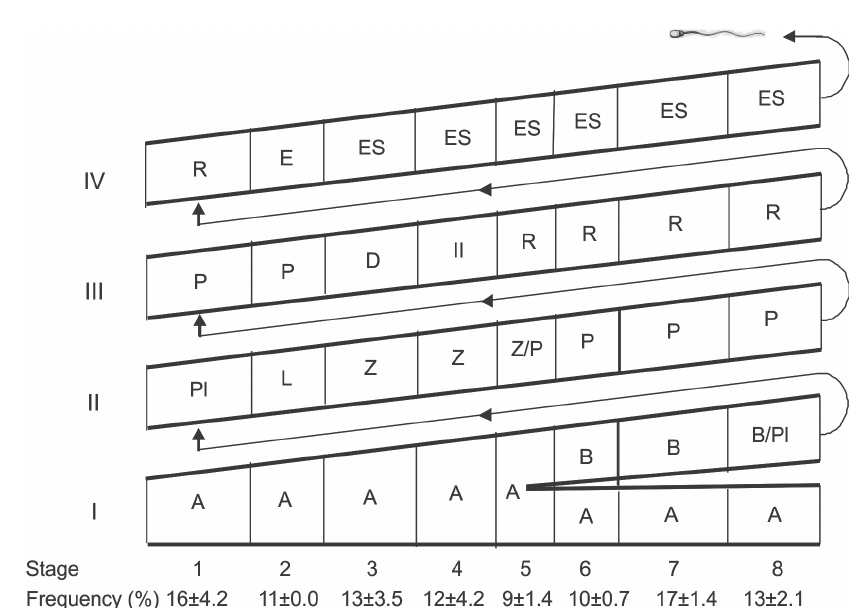
Figure 10. Cell composition and frequency (%) of the stages (1-8) of the cycle (I-IV) of the seminiferous epithelium of the large fruit-eating bat; column width, representing each stage, is proportional to its frequency. (A) Type-A spermatogonium, (B) type-B spermatogonium, (Pl) primary spermatocytes in preleptotene, (L) primary spermatocytes in leptotene, (Z) primary spermatocytes in zygotene, (P) primary spermatocytes in pachytene, (D) primary spermatocytes in diplotene, (II) secondary spermatocytes, (R) round spermatids, (E) elongating spermatids, (ES) elongated